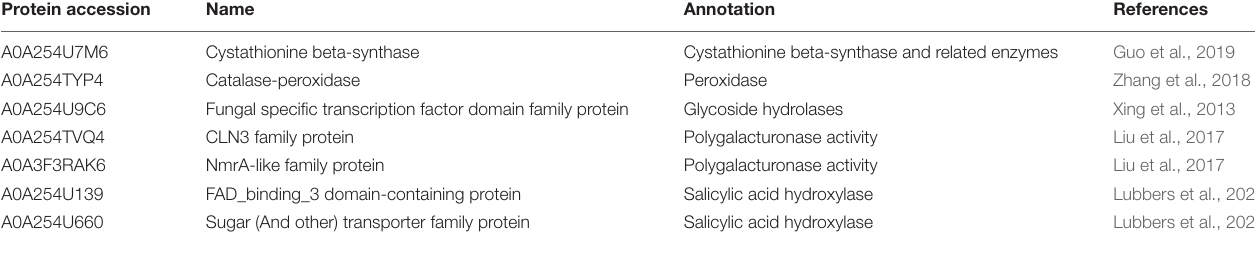
TABLE 1 | List of identified Khib proteins involved in pathogenesis in A. niger .